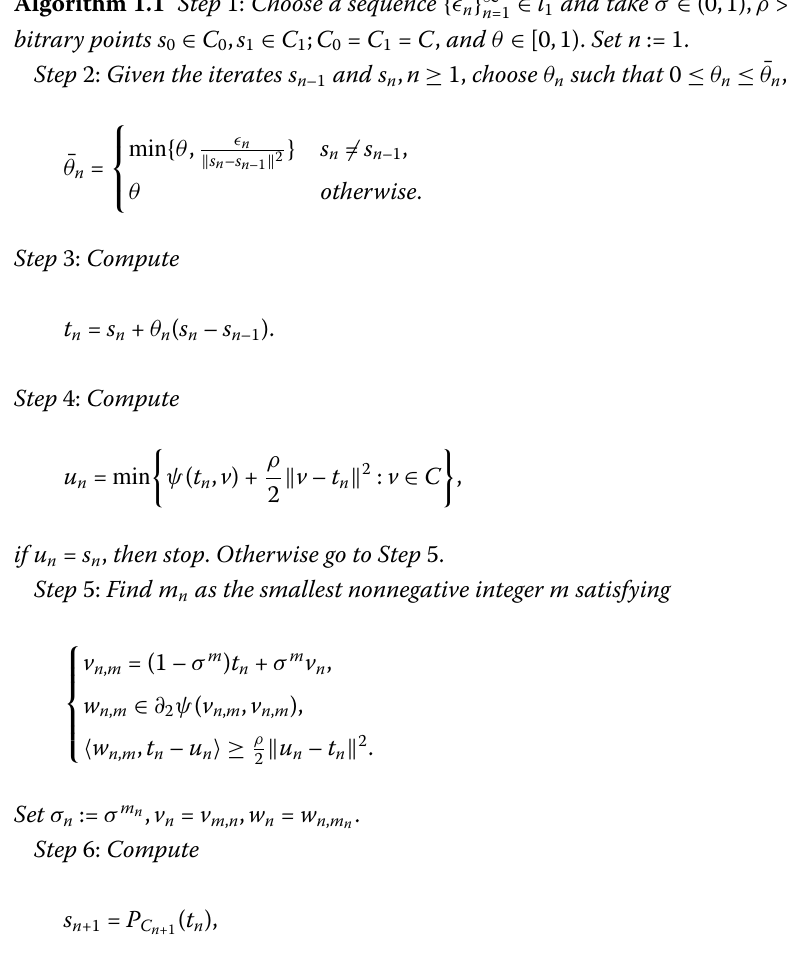
Algorithm 1.1 Step 1: Choose a sequence { (cid:3) n } ∞